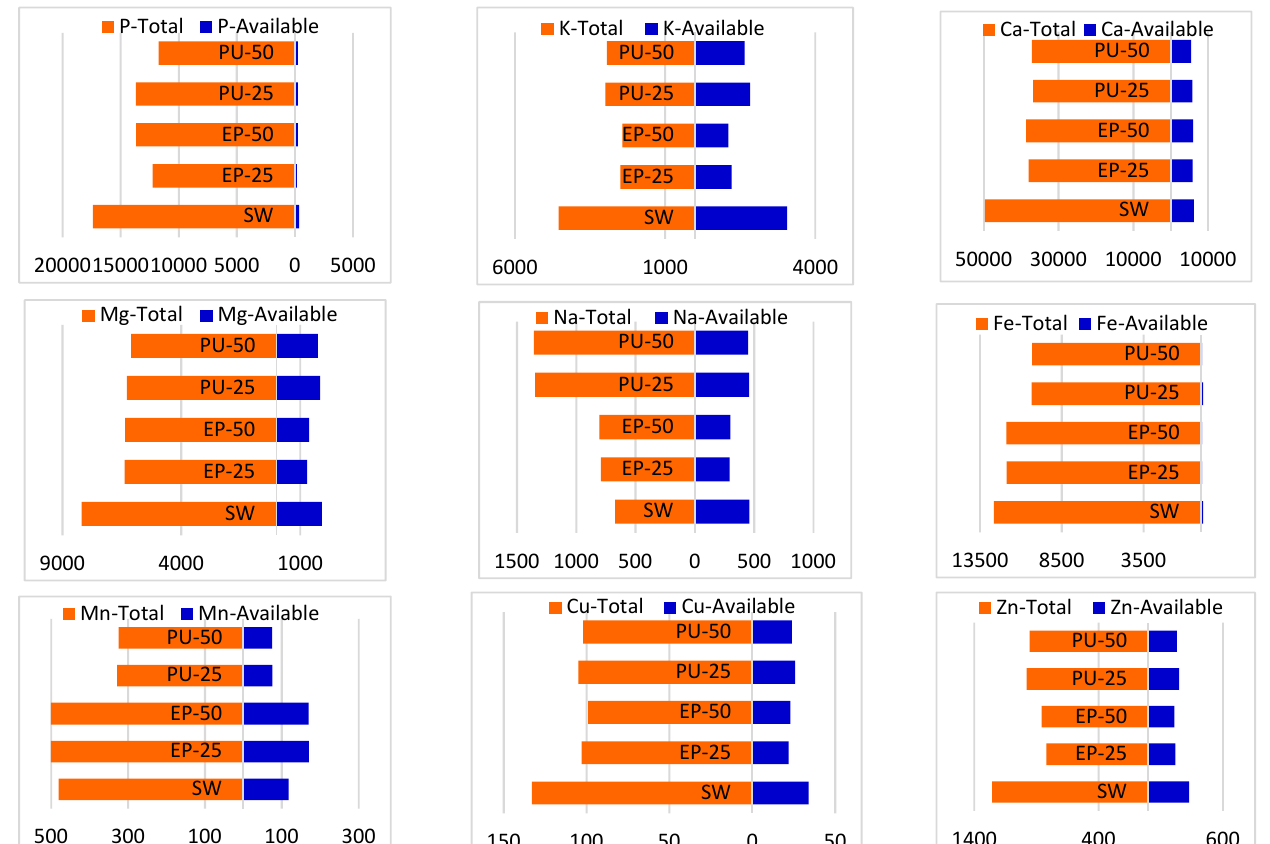
Figure 4. Bi-directional presentation of total and bioavailable plant nutrients (mg kg −1 dry weight basis) of compost samples composted with increasing rate of the PU and EP comparing to the SW- control. SW sawdust, EP expanded perlite, and PU pumice at 25, and 50% incorporation rate into compost mixture.